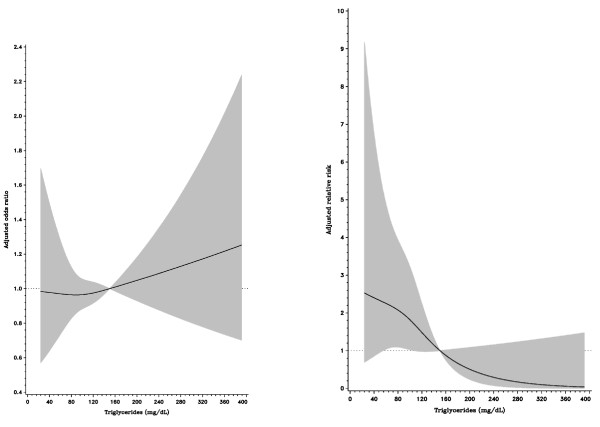
Relationship between triglyceride concentrations and the risk of acute coronary syndrome event (left) and all-cause death after event (right). The multivariate adjusted relative risks were plotted as a function of the baseline triglyceride value with the 95% confidence bands shown as the shaded area.